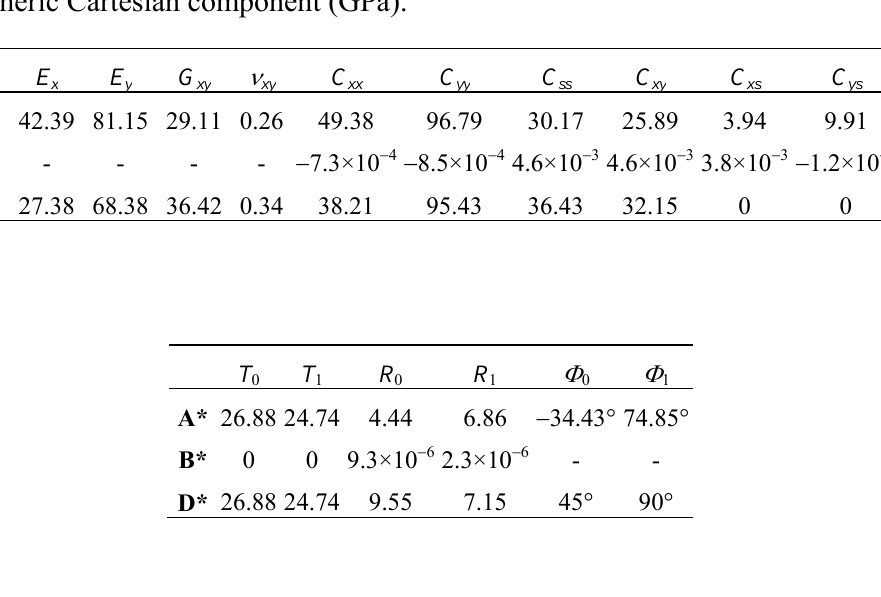
Table 5. Example 2: technical, Cartesian and polar constants of the best solution laminate; C is a generic Cartesian component ij